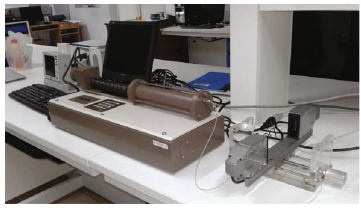
Figure 4: Experimental setup.